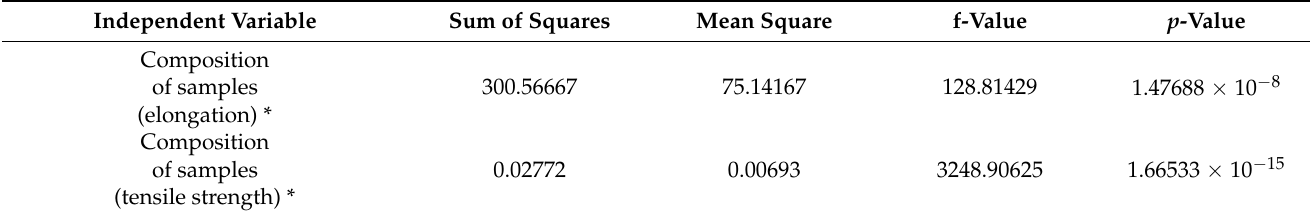
Table 6. Statistical analysis of obtained data based on the one-way analysis of variance (ANOVA) with repetitions.